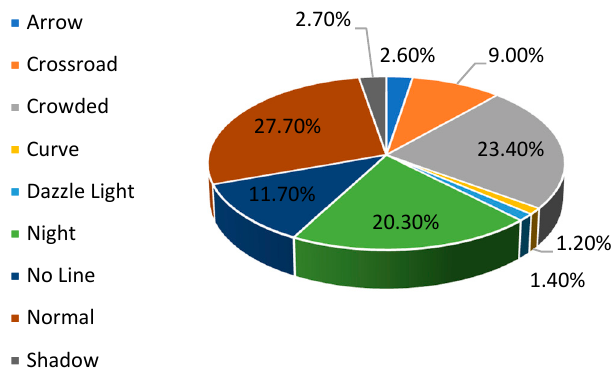
Figure 5. Percentage of each